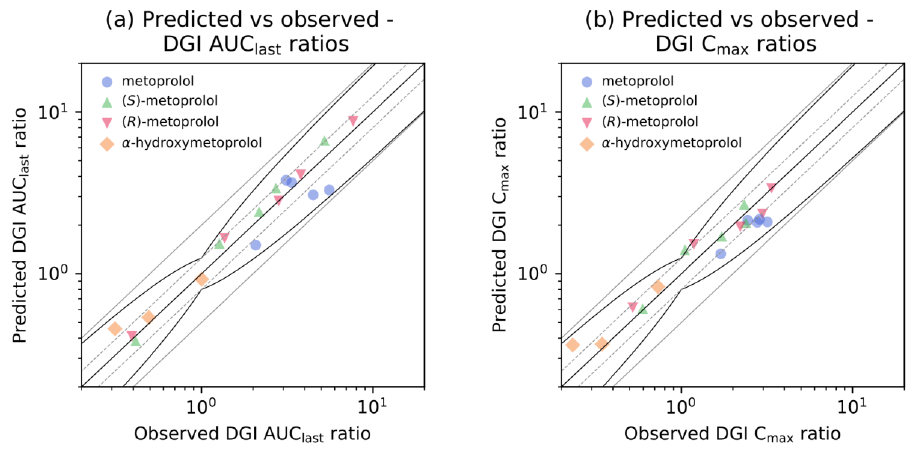
Figure 5. Predicted versus observed metoprolol DGI ratios. Comparison of predicted versus observed Figure 5 ( a ) DGI AUC last ratios and ( b ) DGI C max ratios for all analyzed metoprolol CYP2D6 DGI studies. The straight black line indicates the line of identity, curved black lines show prediction success limits proposed by Guest et al. including 1.25-fold variability [52]. Solid grey lines indicate two-fold deviation, dashed grey lines show 1.25-fold deviation. Detailed information on all clinical studies as well as the plotted values are listed in Tables S2.2.1 and S3.3.2 of the Supplementary Materials. AUC last : area under the plasma concentration-time curve from the time of the first concentration measurement to the time of the last concentration measurement, C max : maximum plasma concentration, DGI: drug-gene interaction, vs: versus.